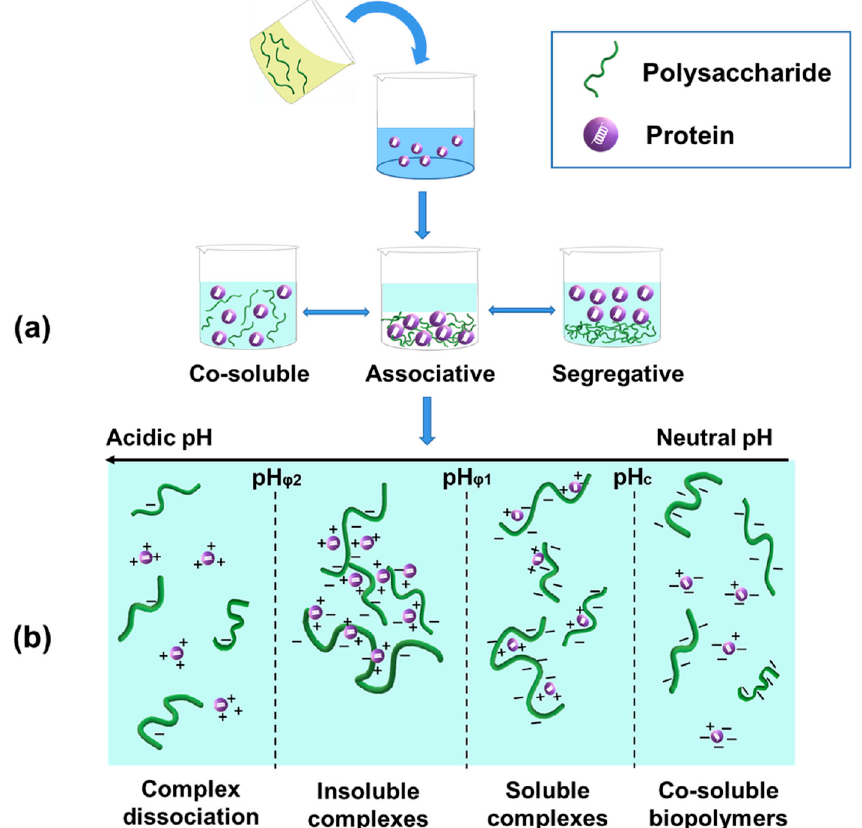
Figure 1. ( a ) Formation of different phase systems between proteins and polysaccharides, including co-soluble biopolymers, associative phase separation (complex coacervation), and segregative phase separation (thermodynamic incompatibility). ( b ) A schematic diagram of the transitions of protein–polysaccharide complexes induced by pH changes.